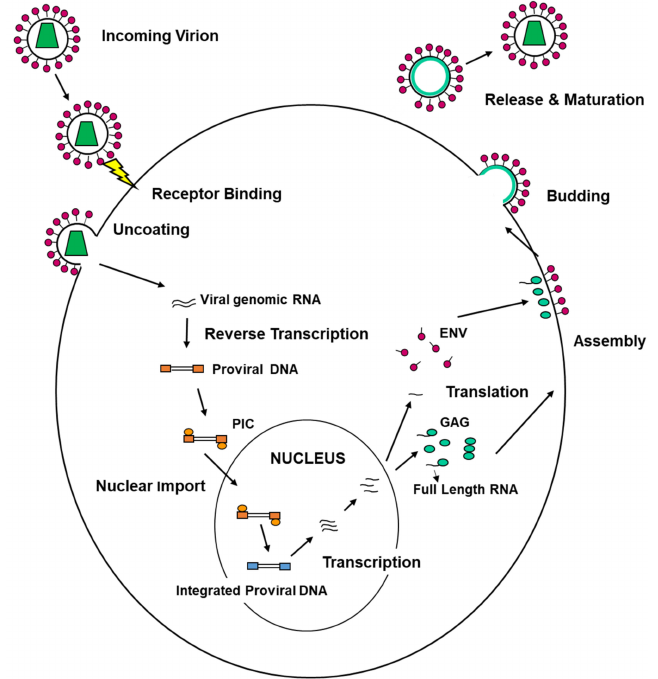
Figure 3. Schematic representation of the main steps in a typical viral life cycle. The figure reports the replication of HIV-1. Upon entry into target cells, mediated by fusion of the viral envelope with the cell surface, the viral genome, which is single-stranded positive RNA (two molecules per viral particle), is partially uncoated from the virion structural proteins, although it is shielded by viral and cellular factors, not entirely known yet (pre-integration complex, PIC). PIC travels to the nucleus and, at the same time, the viral RNA is retrotranscribed by one of the viral enzymes into double-stranded DNA (provirus). Once entered the nucleus, the proviral DNA is integrated into the cellular genome and becomes part of it. Indeed, it is the cellular RNA polymerase II that transcribes the integrated provirus in mRNAs that are translated into the cytosol to give rise to the structural proteins Gag-Pol and Env. The first one drives—in concert with cellular proteins—the assembly and egress of the progeny virions. The latter enriches the viral envelope and is essential to bind the cellular receptors during the next replication round. Regulatory and accessory proteins are also translated. Furthermore, full-length genomic RNAs are also produced to be packaged into the novel budding particles. Once released in the extracellular environment, the new virions terminate their maturation, and they become infectious. Different viruses, due to the specific biological features (in a particular type of genome and presence or absence of an envelope), might differently execute the steps of their life cycle. However, the main steps remain the same: entry, uncoating, genome replication and transcription, protein translation, assembly of progeny virions, egress from infected cells. These stages may present certain differences in the different viral families, also due to the different biological features that characterize each family itself (with the type of genomic nucleic acids and presence or absence of a lipid envelope enwrapping the particle as the main ones in this context). What remains a common trait is the necessity for the virus to interact with the cellular apparatus throughout its replication. This is also the main reason why viruses can alter cell functions, thus causing a disease, and are all